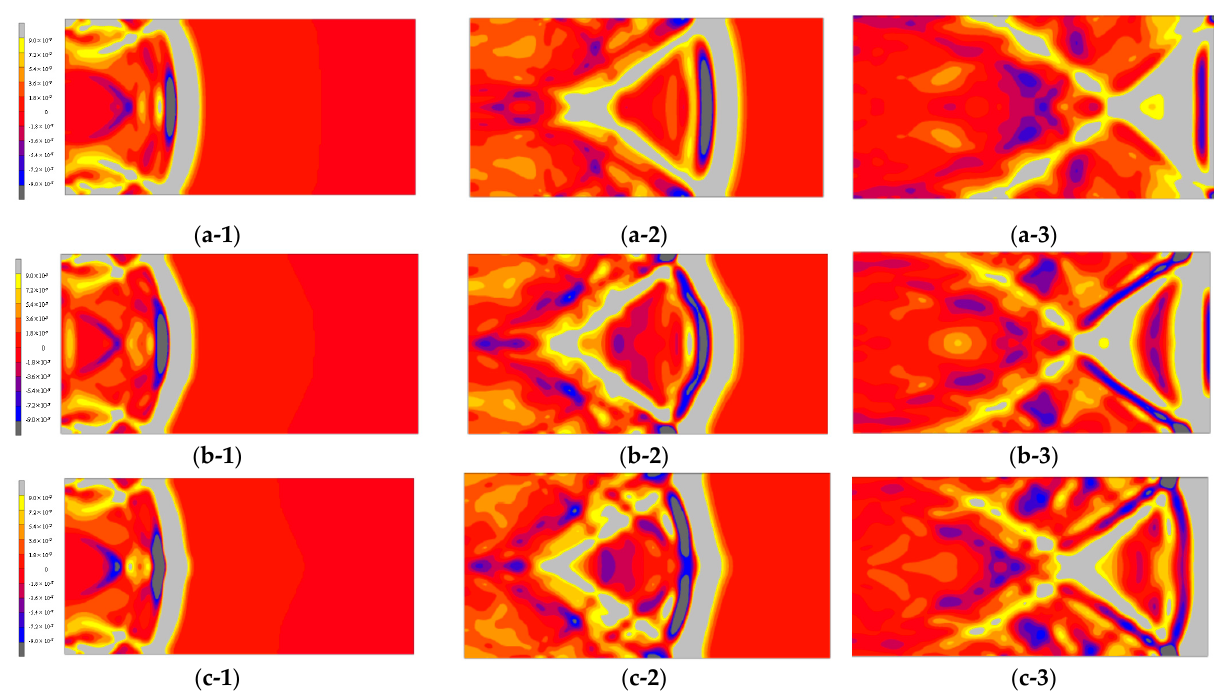
Figure 11. Analysis results of the two-dimensional waveforms: ( a-1 ) dry depth = 5 mm at 20 µs, ( a-2 ) dry depth = 5 mm at 40 µs, ( a-3 ) dry depth = 5 mm at 60 µs, ( b-1 ) dry depth = 30 mm at 20 µs, ( b-2 ) dry depth = 30 mm at 40 µs, ( b-3 ) dry depth = 30 mm at 60 µs, ( c-1 ) dry depth = 45 mm at 20 µs, ( c-2 ) dry depth = 45 mm at 40 µs, and ( c-3 ) dry depth = 45 mm at 60 µs.